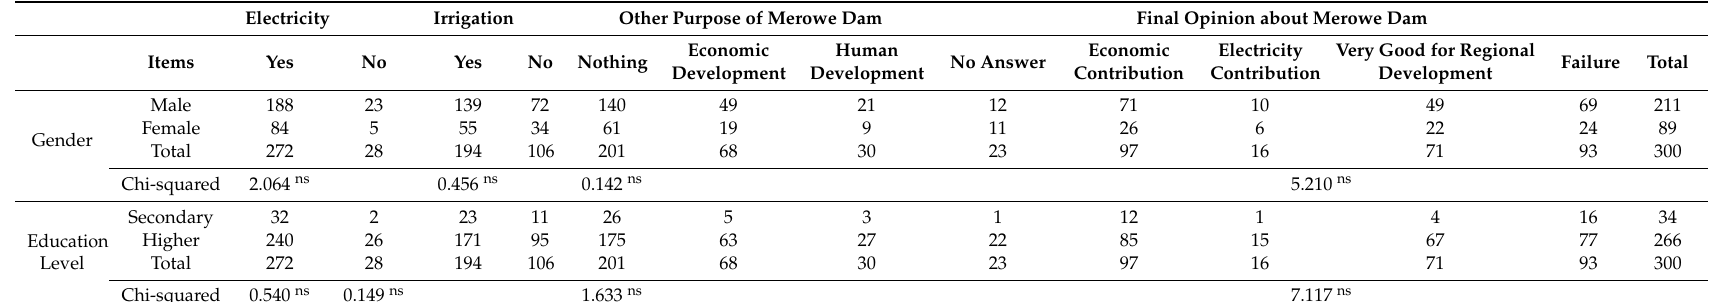
Table 3. Participants’ perception on Merowe Dam’s agricultural and non-agricultural economic benefits by gender and educational level. Electricity Irrigation Other Purpose of Merowe